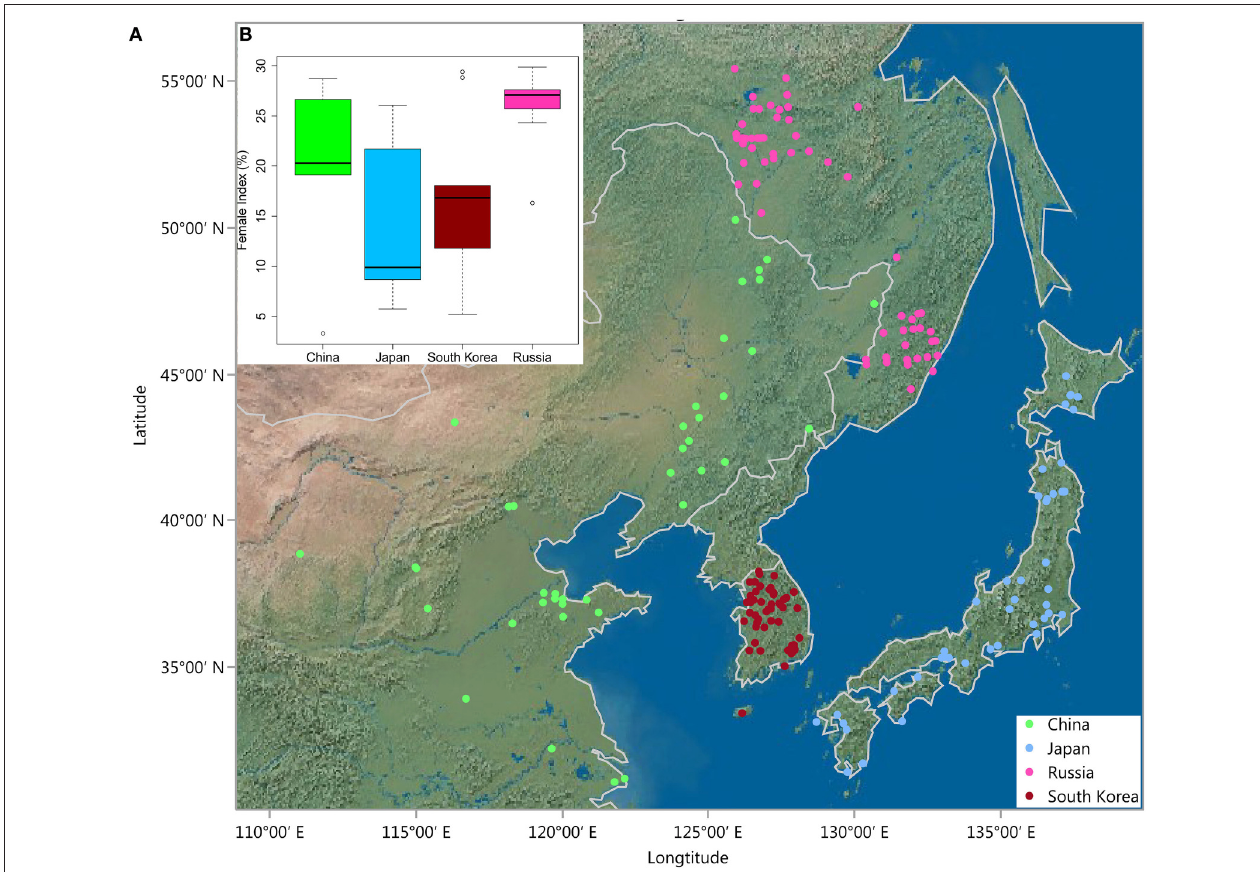
FIGURE 1 | (A) Geographic distribution of 235 G. soja accessions in East Asia. (B) Box plot showing differences in female index (FI < 30) between four countries in East